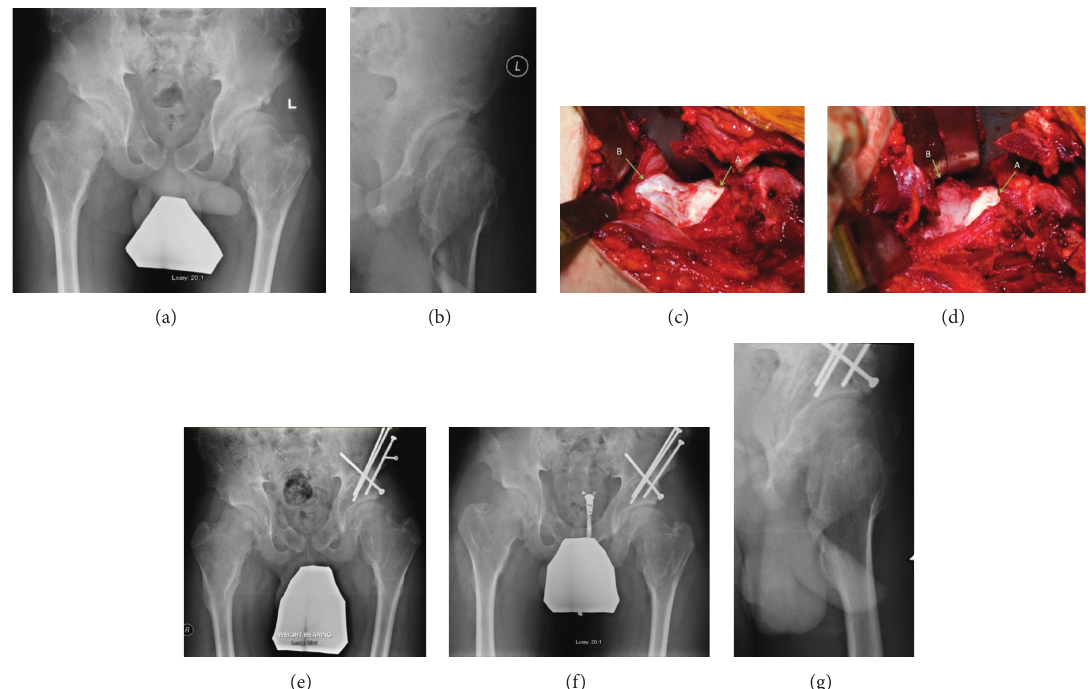
Figure 1: (a) Preoperative anteroposterior pelvic radiograph. (b) Preoperative false profile view showing poor anterior femoral head coverage. (c) Intraoperative images showing the location of the femoral head (arrow A) and the femoral neck osteochondroma (arrow B). (d) Postpartial excision of osteochondroma (arrow B) and the location of the femoral head (arrow A). (e) Anteroposterior pelvic radiograph at 1-year follow- up. (f) Anteroposterior pelvic radiograph at 18 months of follow-up. (g) False profile pelvic radiograph at 18 months of follow-up showing improved anterior